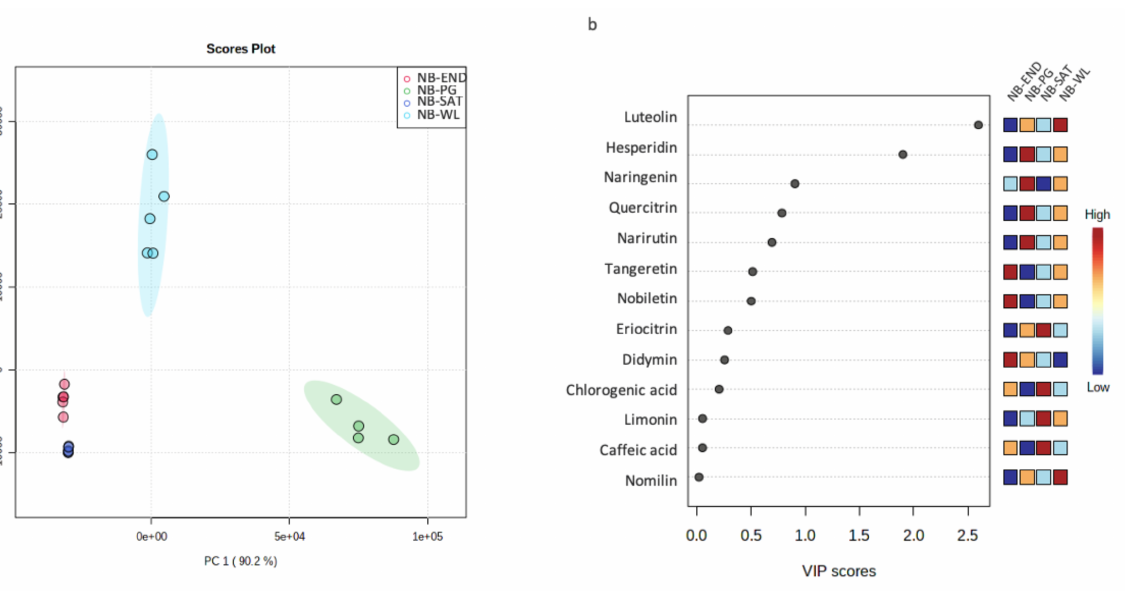
Figure 3. ( a ) PCA plot of the four varieties of mandarin leaf in their non-bearing stage: ‘Ellendale’ (NB-END), ‘Willowleaf’ (NB-WL), ‘Page’ (NB-PG), and ‘Satsuma’ (NB-SAT); ( b ) PLS-DA VIP scores. The concentration of both polymethoxyflavones were different, being highest to lowest: NB-END, NB-WL, NB-SAT, and NB-PG. The flavanone hesperidin was highest for the duad WL-PG; the same behavior was observed for flavanones naringin and naringenin, flavonols, and flavones. Didymin had high concentration values in NB-END and NB-PG, but not in NB-WL and NB-SAT. Hydroxycinnamic acids are present in the highest concentration in NB-SAT variety (Figure 3a, Tables 2 and